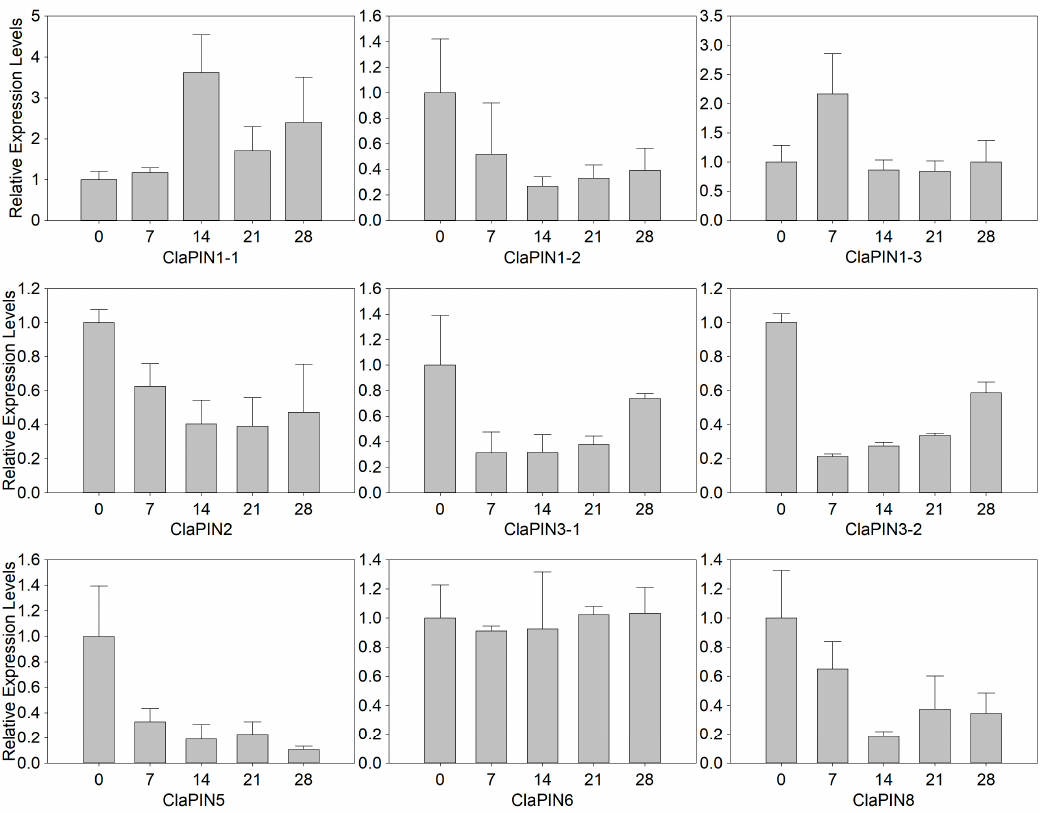
Figure 4. Expression pattern of ClaPINs during shoot regeneration by qRT-PCR. The numbers of the X-axis represent that the samples were collected at 0, 7, 14, 21, and 28 days after incubation.